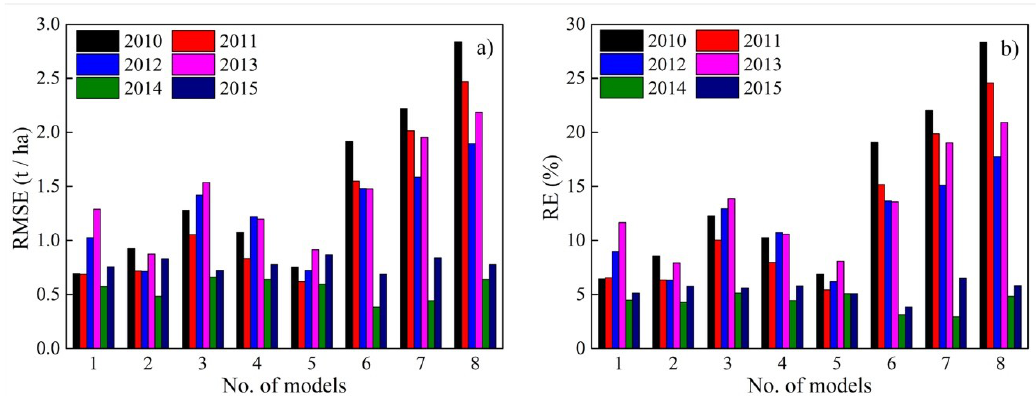
Figure 4. The RMSE ( a ) and RE ( b ) of RF models for maize yield estimation from 2010 to 2015.